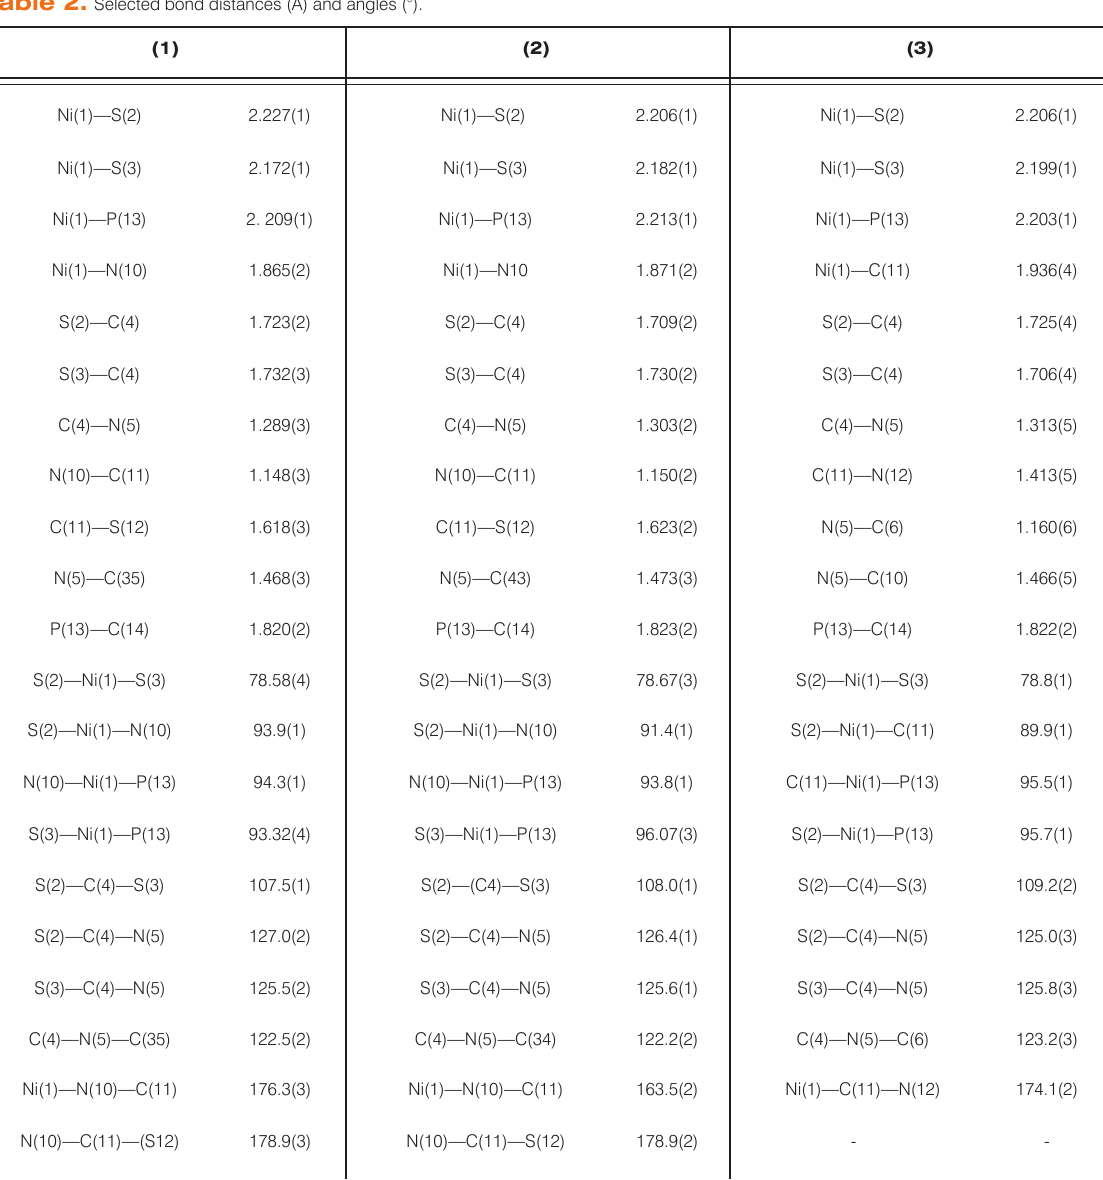
Table 2. Selected bond distances (Å) and angles